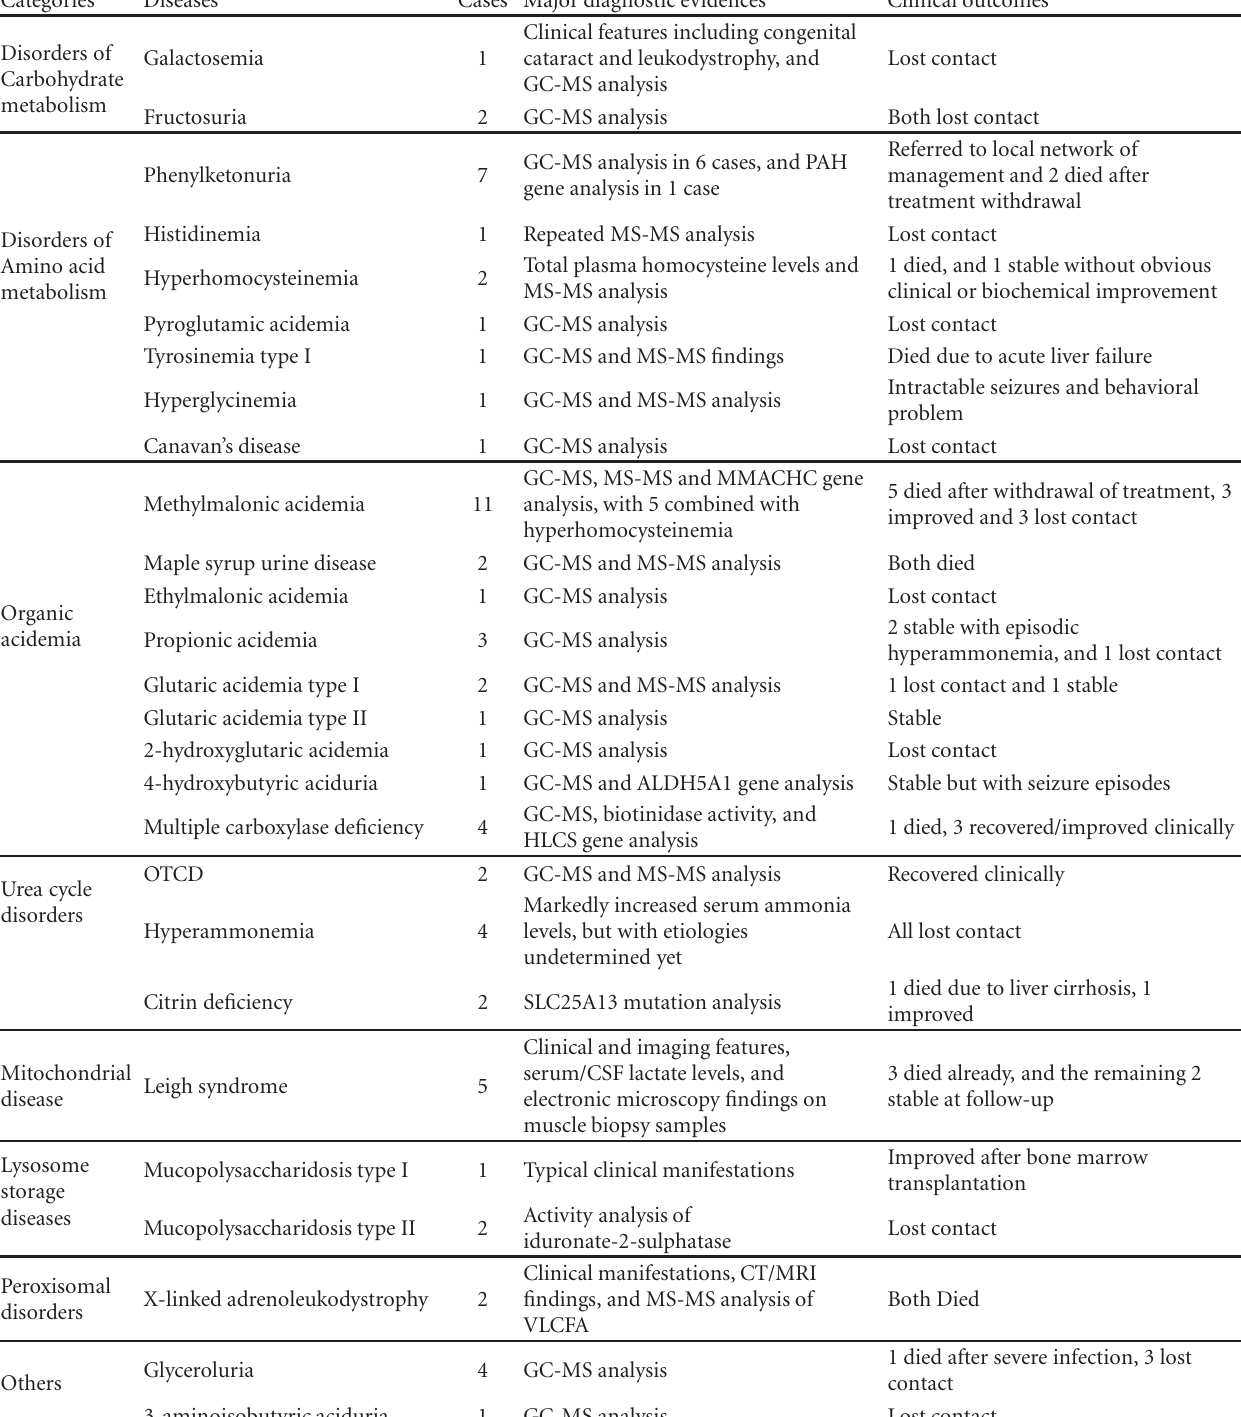
Table 4: Feature of etiology distribution in the patients with IEMs in Table